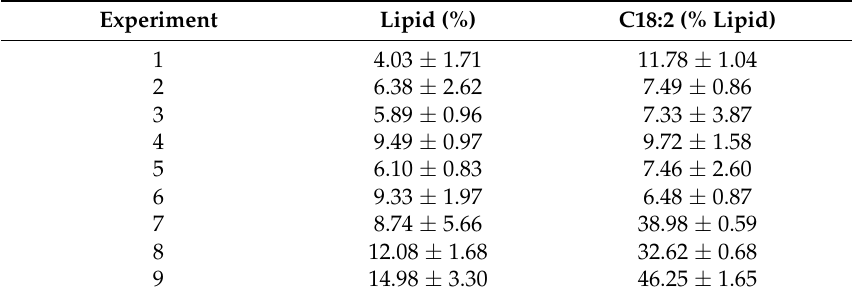
Table 4. Experimental results on the lipid content of the mycoalgae biomass after 120 h of growth and the percentage of C18:2 in regards to the total lipids attained in the